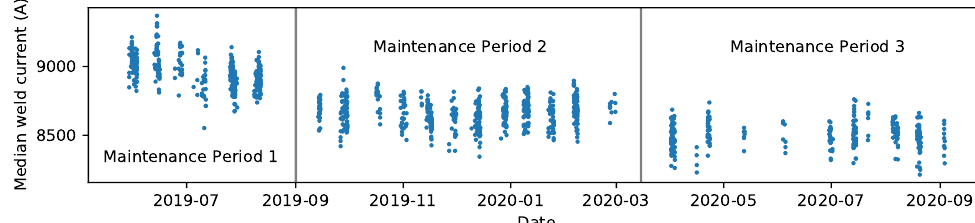
Figure 1. Median measured welding current for all welds made using one often-used welding program; each dot corresponds to one weld. Aside from minor localized trends, there are two major jumps visible. The first jump coincides with the replacement of a welding machine component, while the second jump has no clear explanation. Later maintenance (July 2020) to replace the same part and correct the first jump has no visible effect. We utilize the maintenance period information in the first version of our